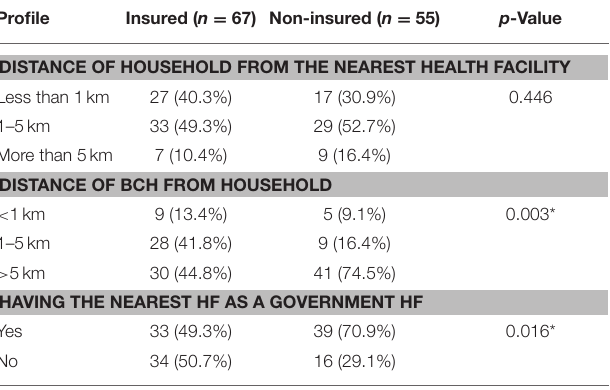
TABLE 9 | Geographical access to BCH among respondents who took a sick child to BCH. Profile